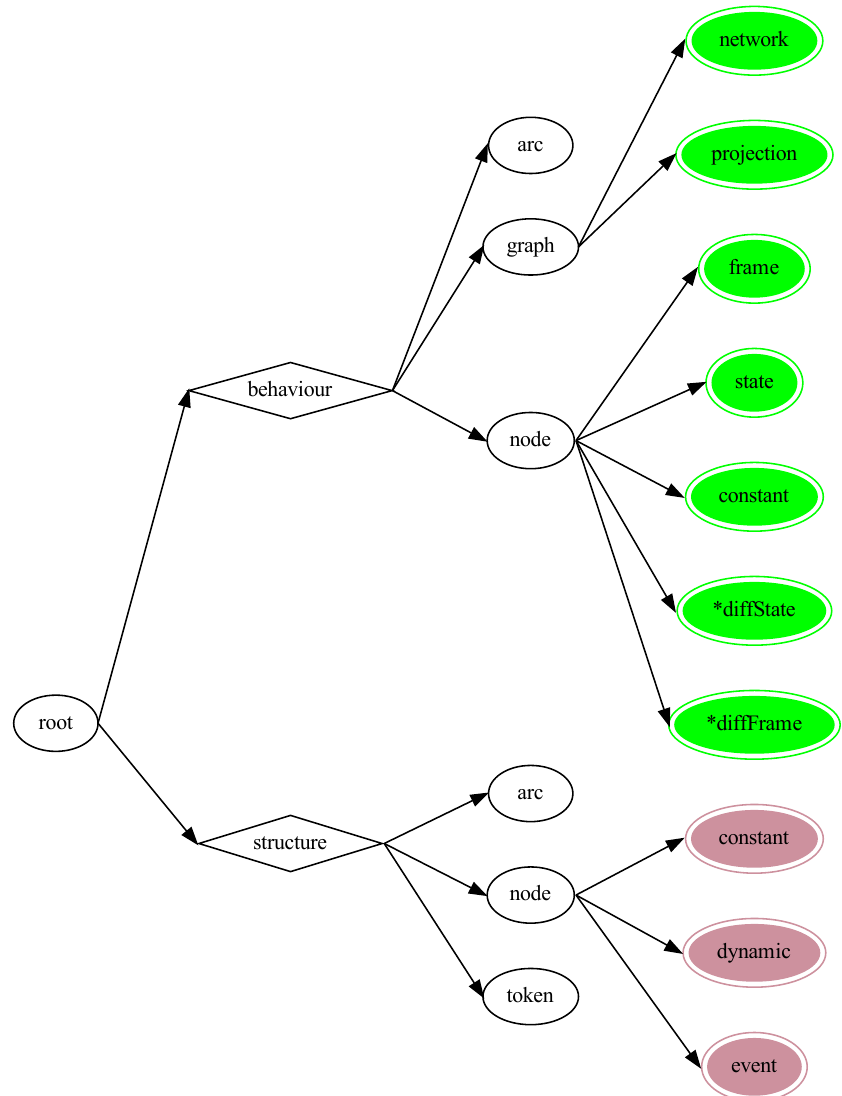
Figure 5. The root node in the discipline tree. It has two branches: the structure branch is used to define the ontology items used for designing the items associated with capturing the model as a directed graph; the behaviour branch serves the purpose of defining the variable classes used to capture the mathematical description of the entity behaviour